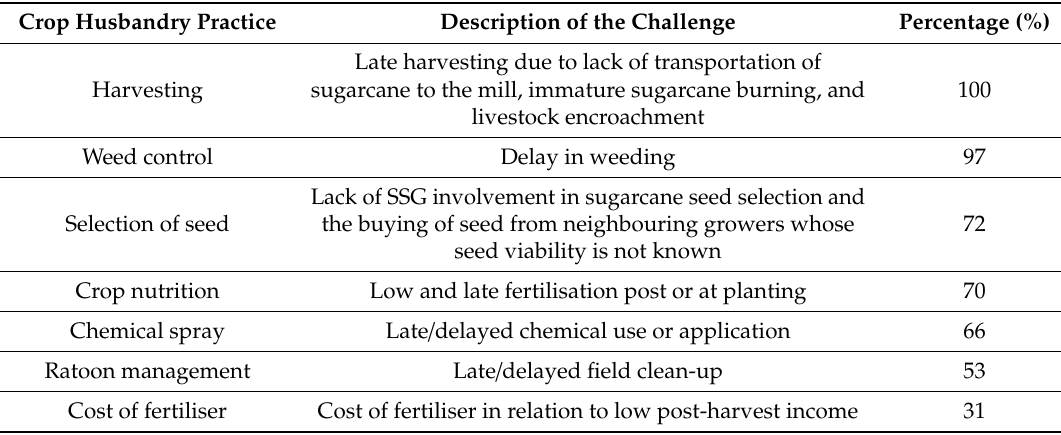
Table 3. Summary of the production challenges faced by small-scale sugarcane growers in Mona and Sonkombo ( n =